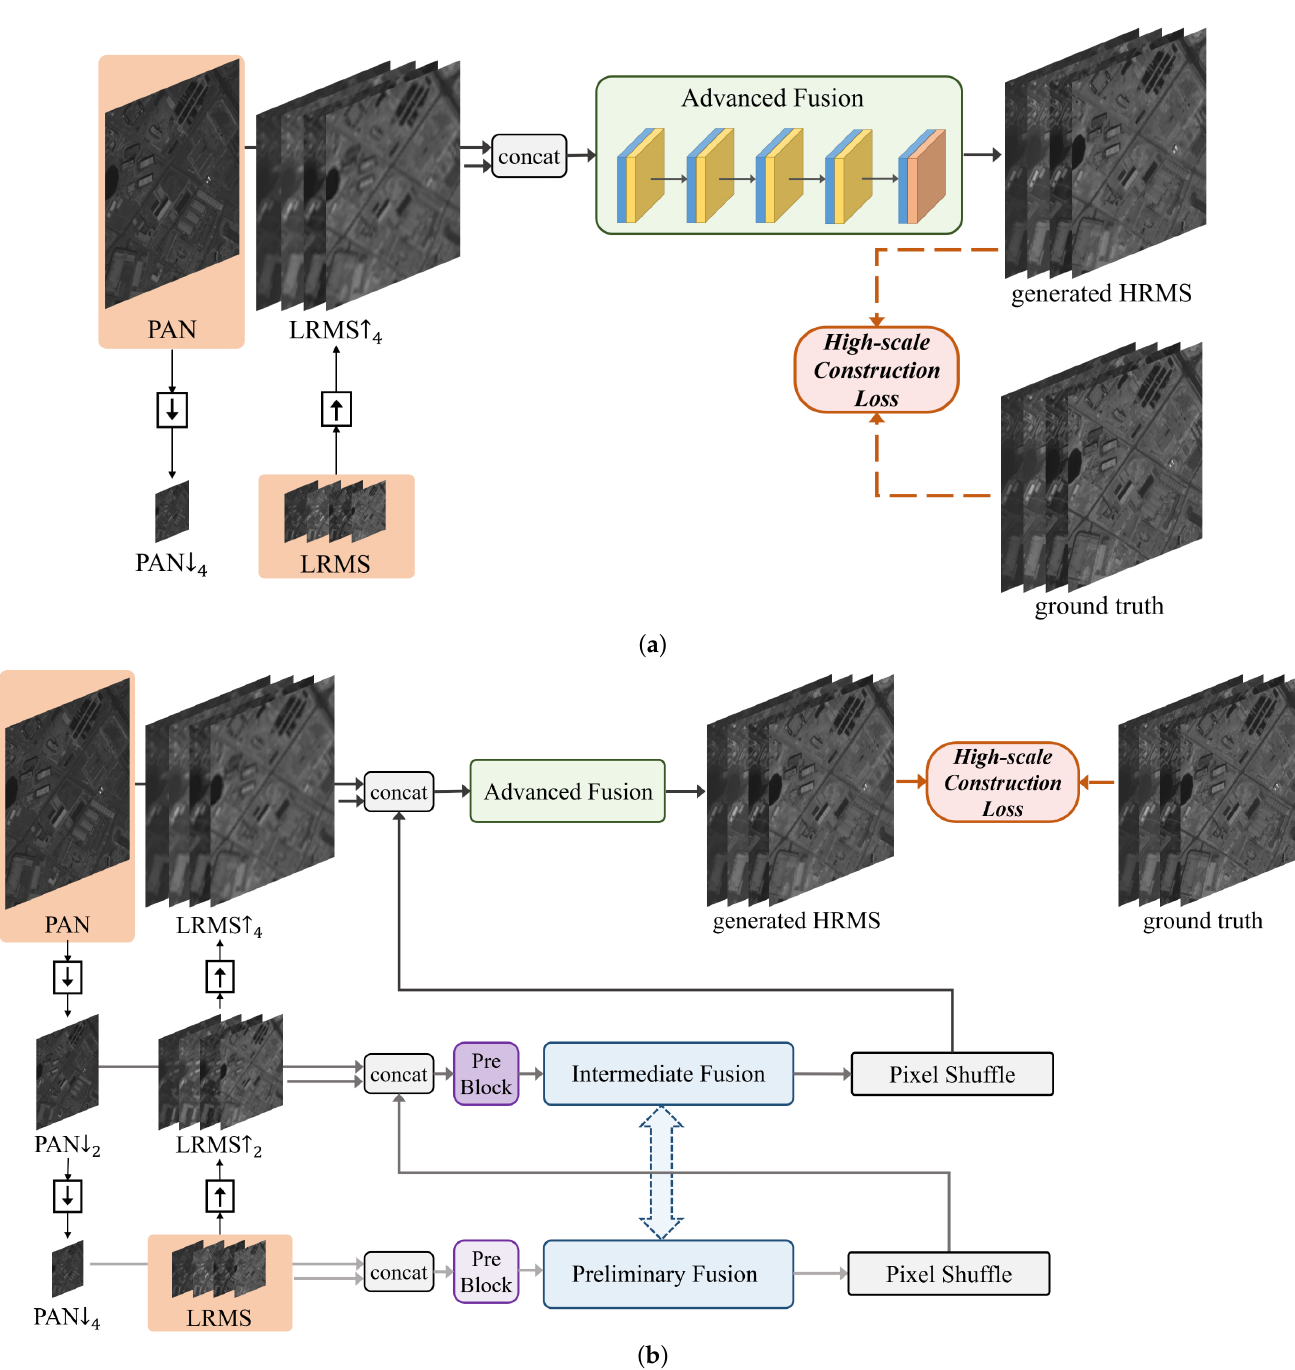
Figure 14. Frameworks of the ablation experiment methods. ( a ) Advanced fusion. ( b ) High-scale loss. The quantitative results of the two ablation methods and the proposed CPNet are of just applying the advanced fusion network showed the worst fusion performance. The method that only applied the high-scale loss showed suboptimal performance, and our CPNet showed optimal performance. More concretely, the best results of our CPNet on ERGAS , RMSE , and SSIM showed that the similarities between the generated HRMS images and the ground truth were the highest. The best results on SAM showed that the spectral quality of our fusion results was similar to that of the ground truth. The best result of our method on SCC indicates that our results preserved the greatest extent of ground